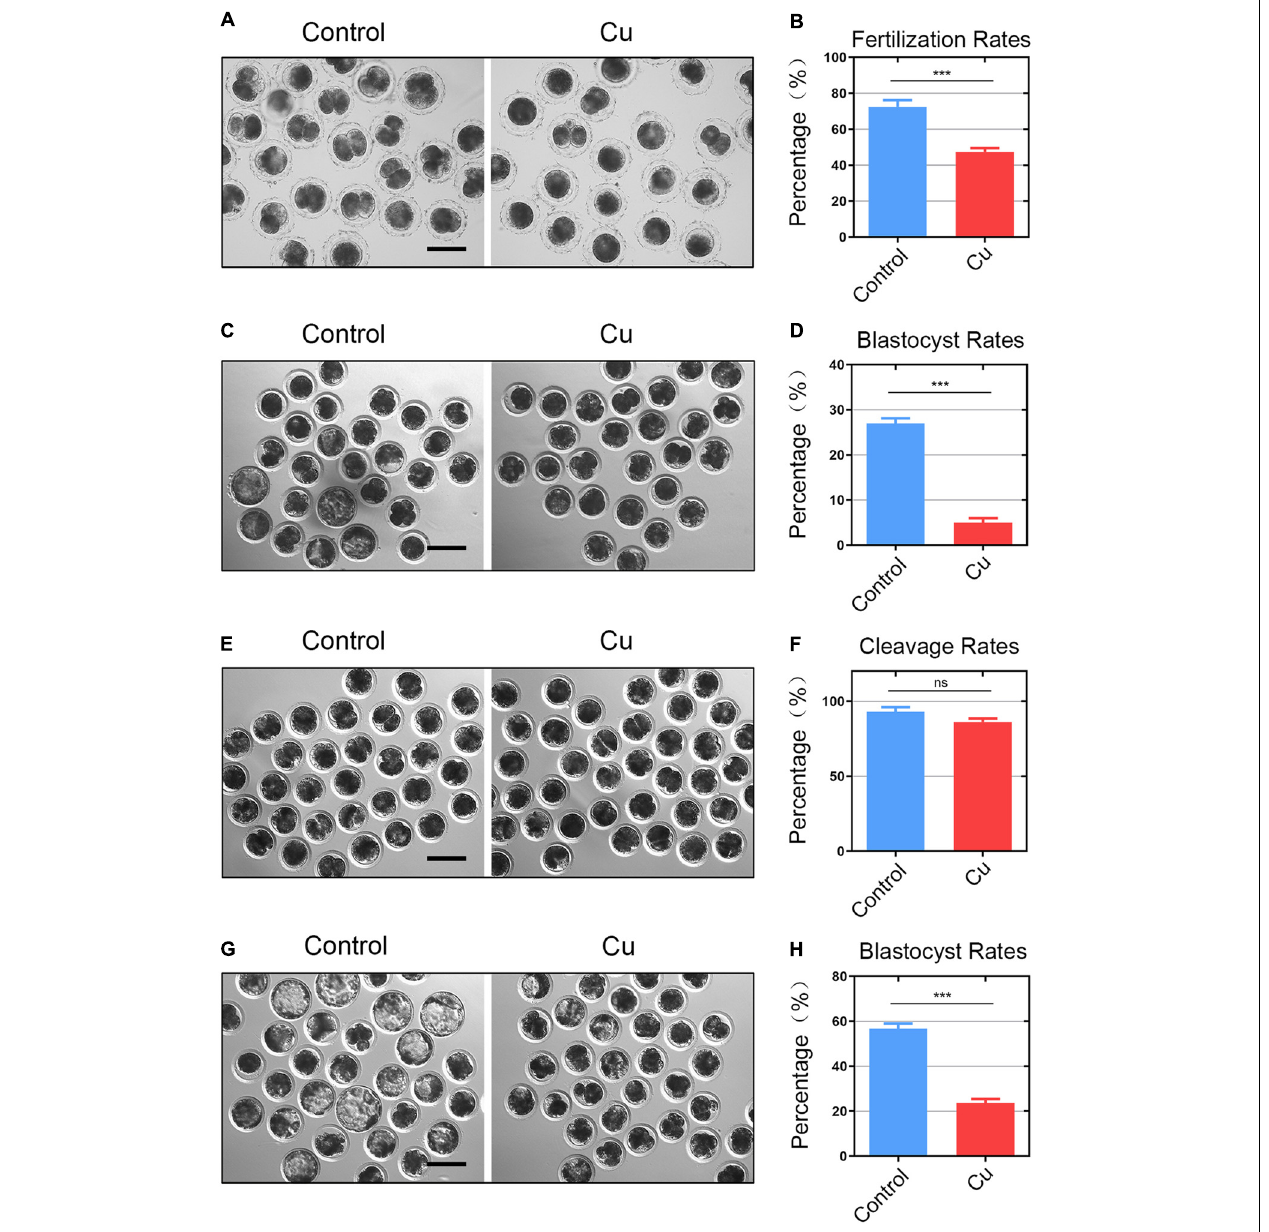
FIGURE 3 | Effects of Cu on the fertilization ability and early embryo development of porcine oocytes. (A) Representative images of the fertilized eggs in the control and Cu-exposed groups. Scale bar, 120 µ m (B) In vitro fertilization rate was recorded in the control groups and the Cu-exposed oocytes. (C) Representative images of the blastocyst rate in the control and Cu-exposed groups after IVF. Scale bar, 100 µ m (D) blastocyst rate was recorded in the control groups and the Cu-exposed oocytes after IVF. (E) Representative images of the parthenogenetic activation rate in the control and Cu-exposed groups. Scale bar, 100 µ m. (F) Parthenogenetic activation rate was recorded in the control groups and the Cu-exposed oocytes. (G) Representative images of the blastocyst rate in the control and Cu-exposed groups after parthenogenetic activation. Scale bar, 100 µ m (H) blastocyst rate was recorded in the control groups and the Cu-exposed oocytes after parthenogenetic activation. Data of (B,D,F,H) were presented as the mean percentage of at least three independent experiments (mean ± SEM). ns: no significance; *** P < 0.001.